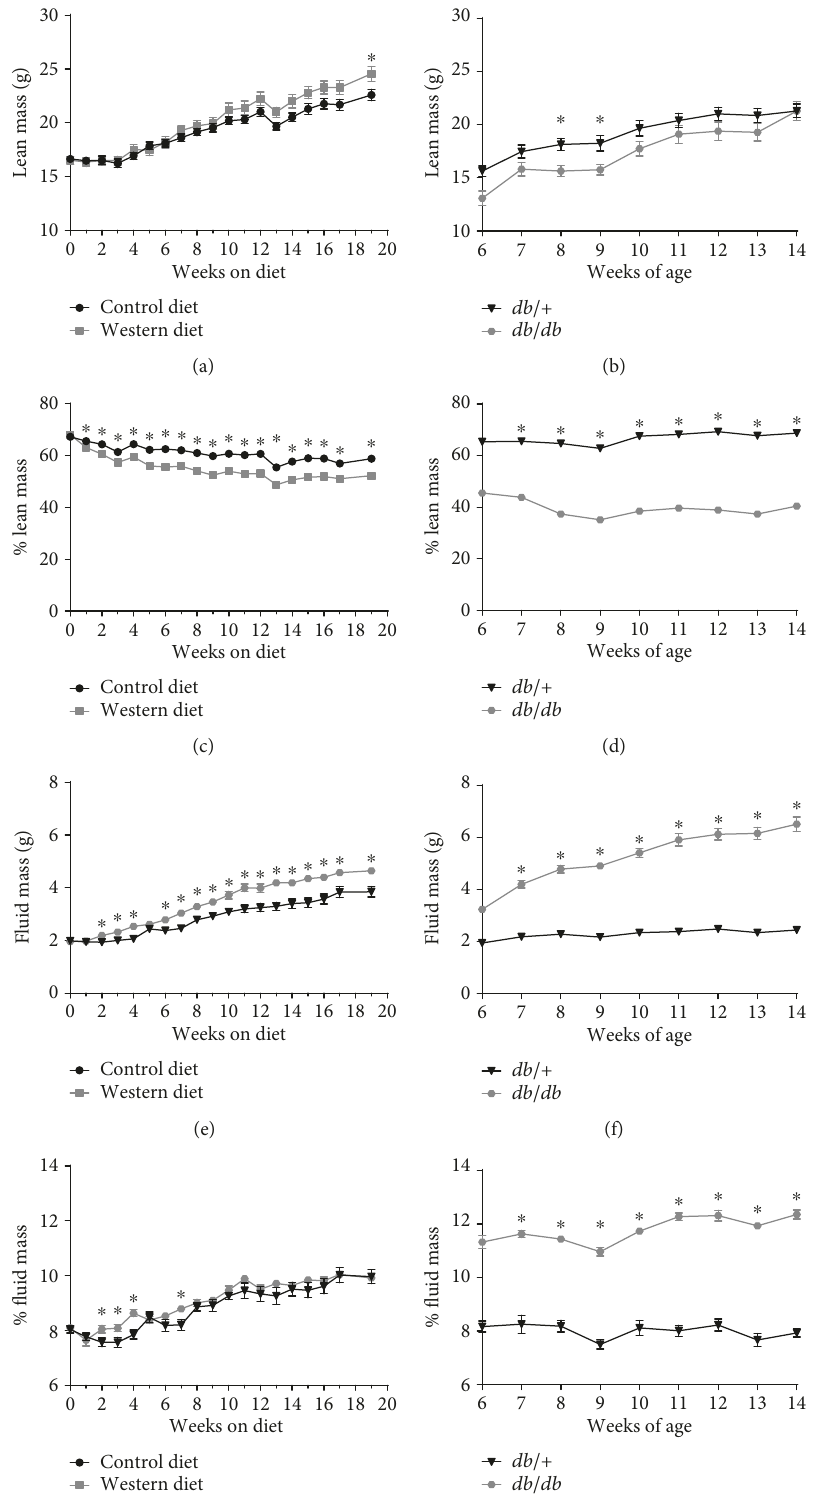
Figure 3: Lean and fl uid mass pro fi les in WD-fed and genetically obese db/db mice. Lean mass (a), % lean mass (c), fl uid mass (e), and % fl uid mass (g) in male C57BL/6J mice fed either control or Western diet for 20 weeks. Lean mass (b), % lean mass (d), fl uid mass (f), and % fl uid mass (h) in male db /+ and db/db mice between 6 and 14 weeks of age. n = 8 per group; means ± SEM; ∗ p < 0 05 versus control by repeated measures